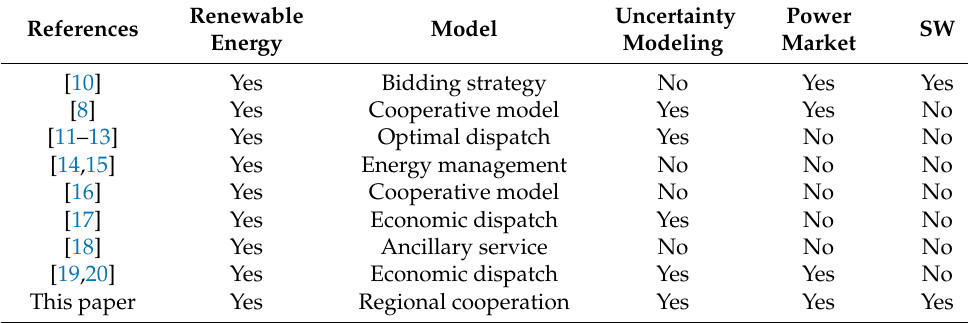
Table 1. Comparison of the proposed method with existing